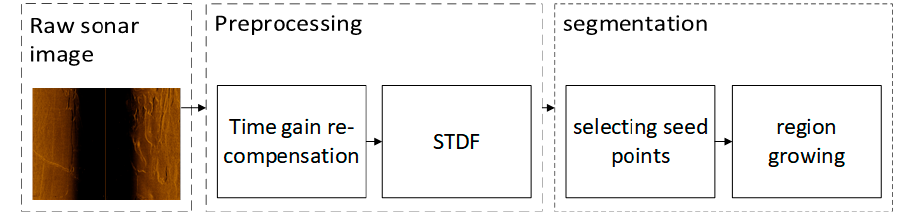
Figure 1. Block diagram of the proposed method